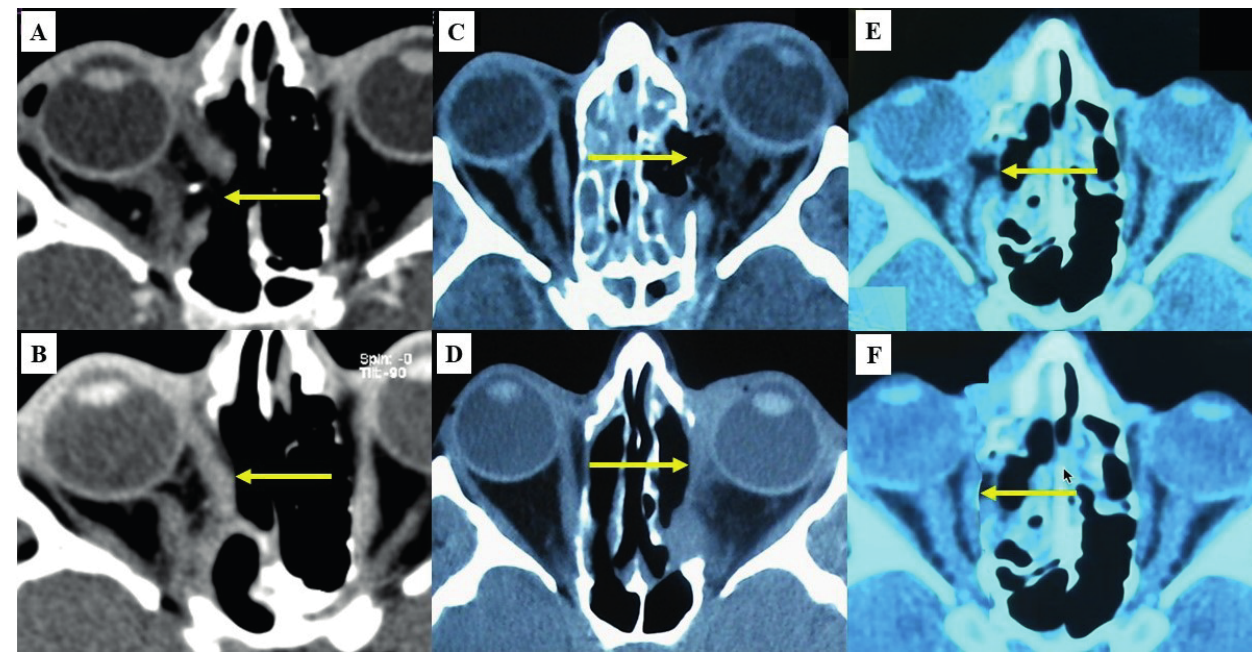
Figure 1. Pre and postoperative axial orbital CT scans. A. Patient 1 pre operative: ruptured right MRM (arrow); B. Patient 1 post operative: sutured right MRM (arrow); C. Patient 2 pre operative: ruptured left MRM (arrow); D. Patient 2 post operative: sutured left MRM (arrow); E. Patient 3 pre operative: ruptured right MRM (arrow); F. Patient 3 post operative: sutured right MRM